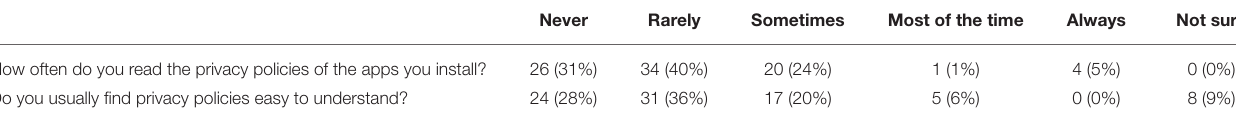
TABLE 8 | Perception of privacy policies ( n = 85).